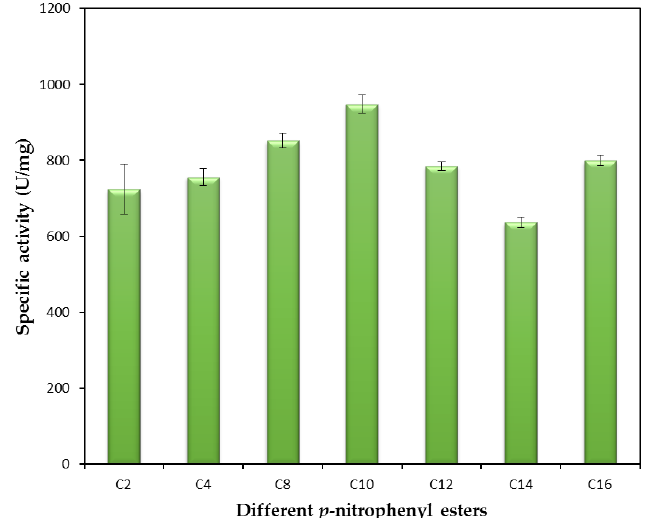
Figure 8. Effect of substrate specificities toward different p -nitrophenyl esters on mature rHZ lipase activity. Data are means ± standard deviations of three determinations ( n = 3) and the standard deviations are indicated as error bars. When the error bar cannot be seen, the deviation is less than the size of the symbol.